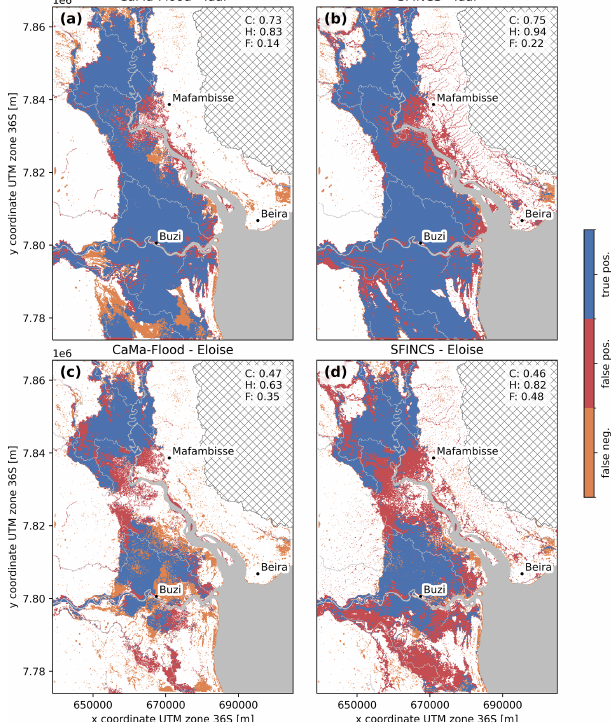
Figure 6. Skill of simulated maximum flood extents from CaMa- Flood (a, c) and SFINCS (b, d) based on satellite-derived flood ex- tents for Tropical Cyclone Idai (a, b) and Tropical Cyclone Eloise (c, d) , evaluated based on the critical success index ( C ), hit rate ( H ) and false-alarm ratio ( F ) as shown in the top right of each panel. The grey areas indicate permanent water, and the hatched areas are excluded as these areas drain to other basins.